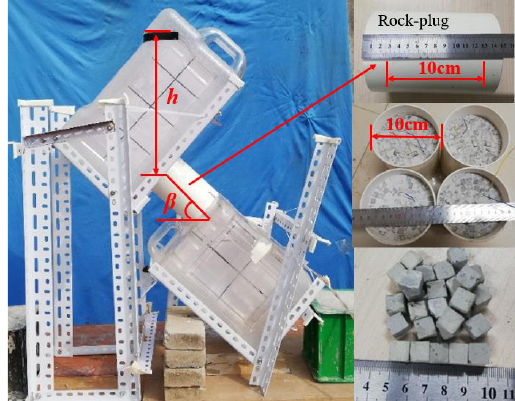
Figure 2. Experimental device and samples. Table 1. Mechanical parameters of concrete. Table 1. Mechanical parameters of